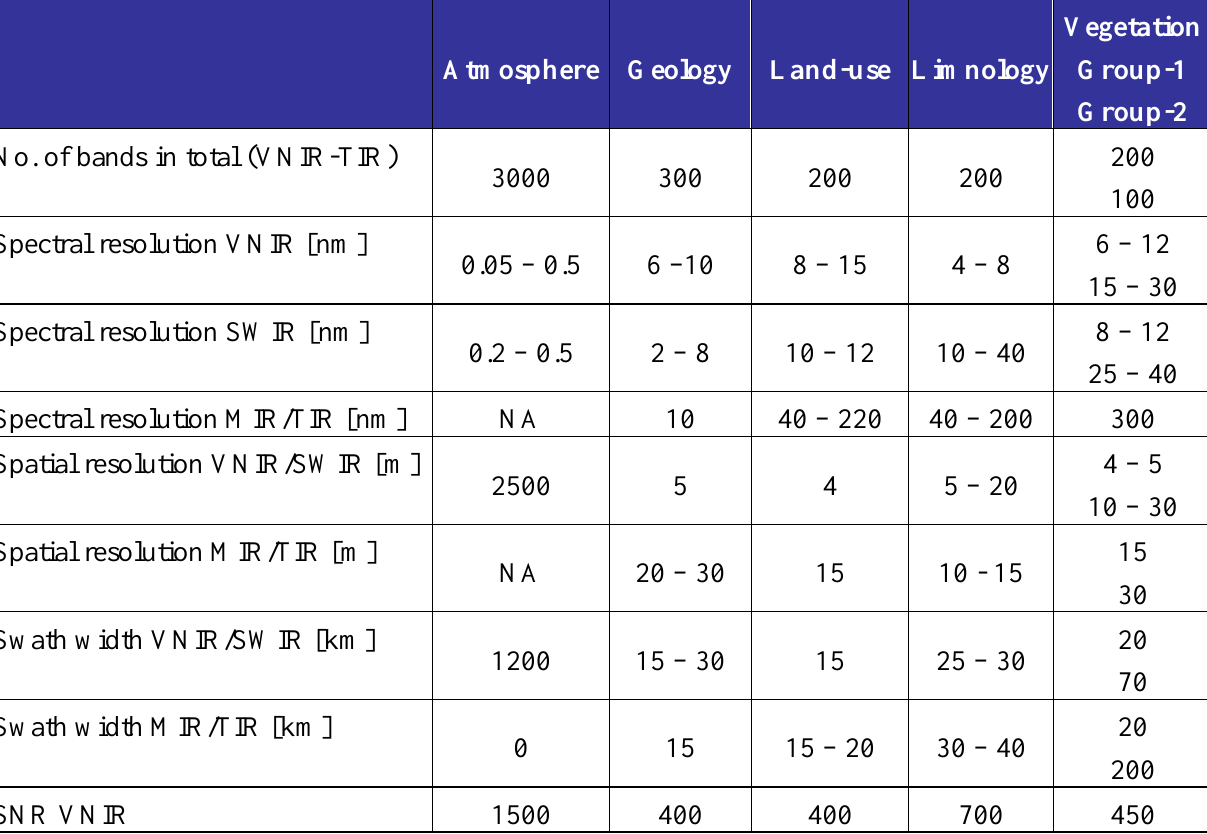
Table 4. User requirements as result of the VBA including also the two vegetation sub-groups (Group-1: bio-chemical, Group-2: